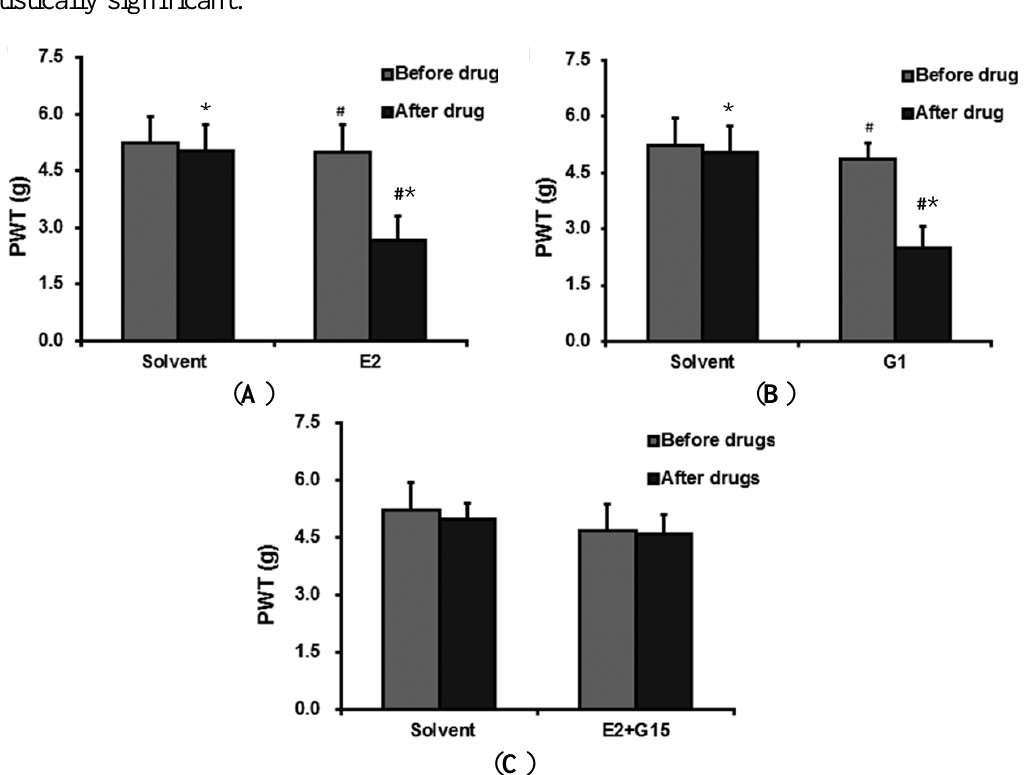
Figure 2. ( A ) The PWT of rats before and 30 min after the administration of solvent and E2 through the caudal vein. The PWT dropped significantly 30 min after administration of E2. * p < 0.05, compared with PWT before the administration; # p < 0.05, compared with the PWT of the solvent group after the drug administration; ( B ) The PWT of rats before and 30 min after the administration of solvent and G1 through the caudal vein. The PWT dropped significantly 30 min after G protein-coupled estrogen receptor (GPER)-selective agonist (G1) administration. * p < 0.05, compared with the PWT before the administration; # p < 0.05, compared with the PWT of the solvent group after the drug administration; and ( C ) The PWT of rats before and 30 min after the administration of solvent and G15 + E2 through the caudal vein. The PWT of the G15 + E2 group decreased but this was not statistically